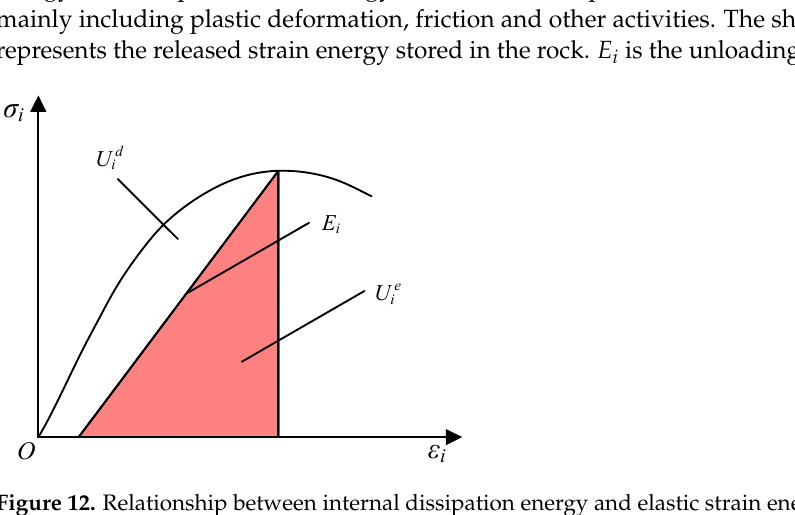
Figure 12. Relationship between internal dissipation energy and elastic strain energy of rock